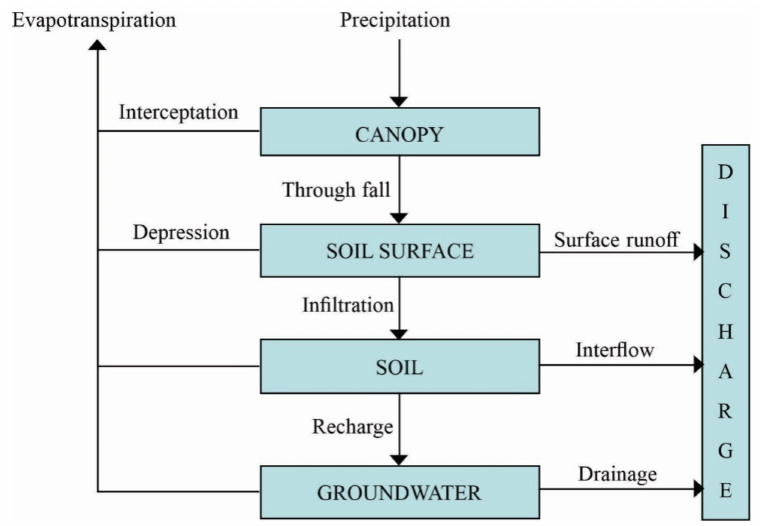
Figure 4. Hydrological processes and WETSPA (water and energy transfer between soils, plants, and atmosphere) model structure